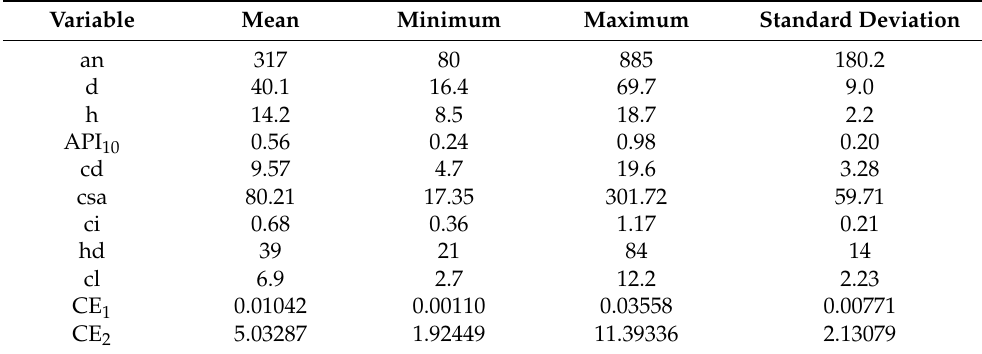
Table 1. Descriptive statistics of dendrometric, morphometric, and number of male strobili for Araucaria angustifolia in the study site for two consecutive years, south Brazil. Variable Mean Minimum Maximum Standard